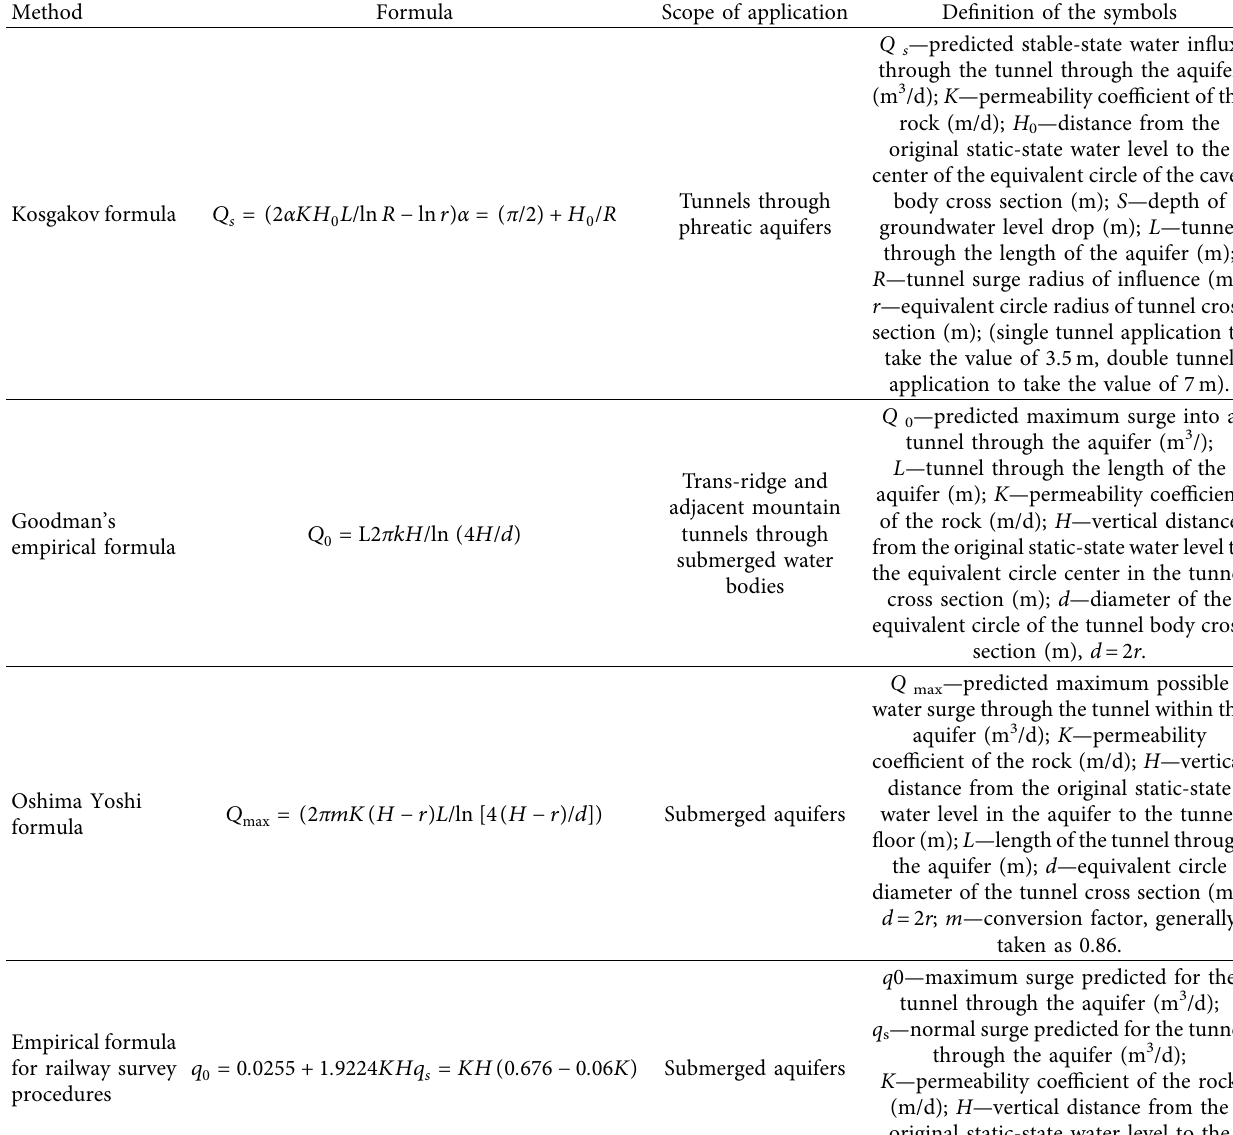
Table 1: List of formulae for the prediction and calculation of the groundwater inflow analytical method.